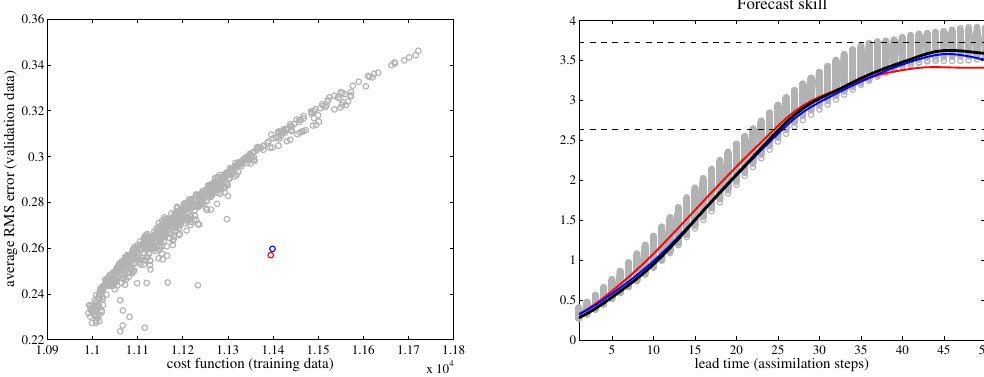
Figure 5. Left panel: negative log likelihood of the training data vs. the average rms error of the filter with the validation data. Right panel: the average forecast rms errors with different covariance matrix parameters. Red and blue colors indicate the results acquired with the full and parametrized “true” model error covariance matrices, respectively. The black line indicates the forecast skill acquired with the parameters that give the smallest negative log likelihood. Dashed vertical lines indicate climatological forecast skill and error saturation level.